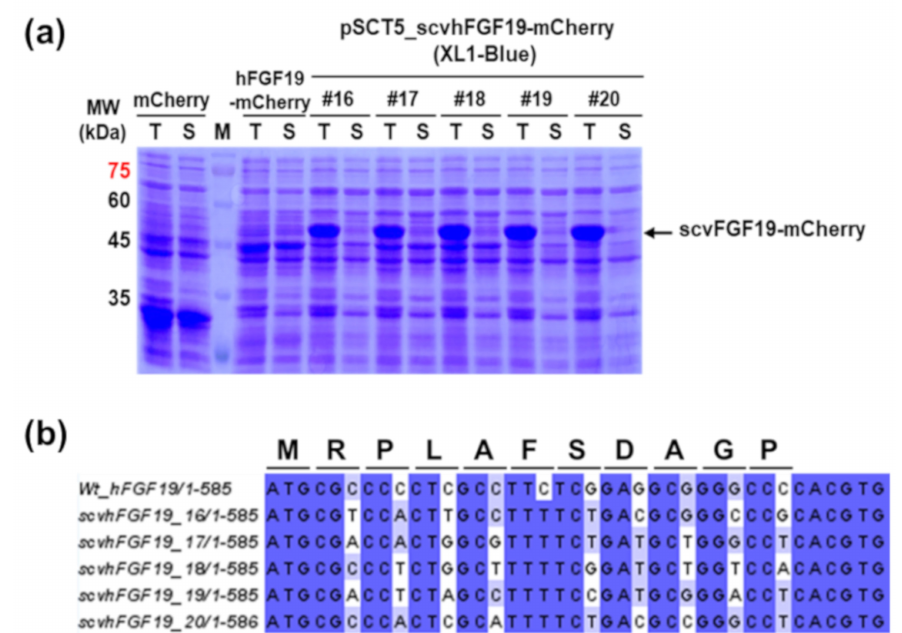
Figure 2. SDS-PAGE analysis and DNA sequence alignment of the selected codon variant scvhFGF19: ( a ) Analysis of the expression of the selected variant scvhFGF19-mCherry fusion proteins. MW: protein size marker; T and S: total and soluble fraction; mCherry: expressed mCherry as a control; hFGF19: mCherry-fused with wild type hFGF19; 16–20: screened codon variant scvhFGF19-mCherry. ( b ) Alignment of DNA sequence of the screened scvhFGF19 with substituted synonymous codons in the N-terminal region.